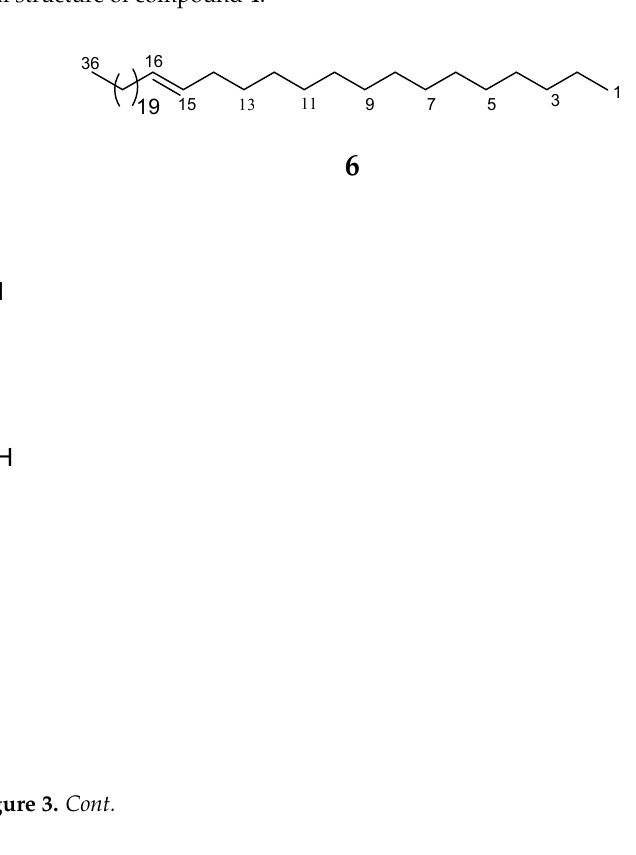
Figure 2. Chemical structure of compound 4 .